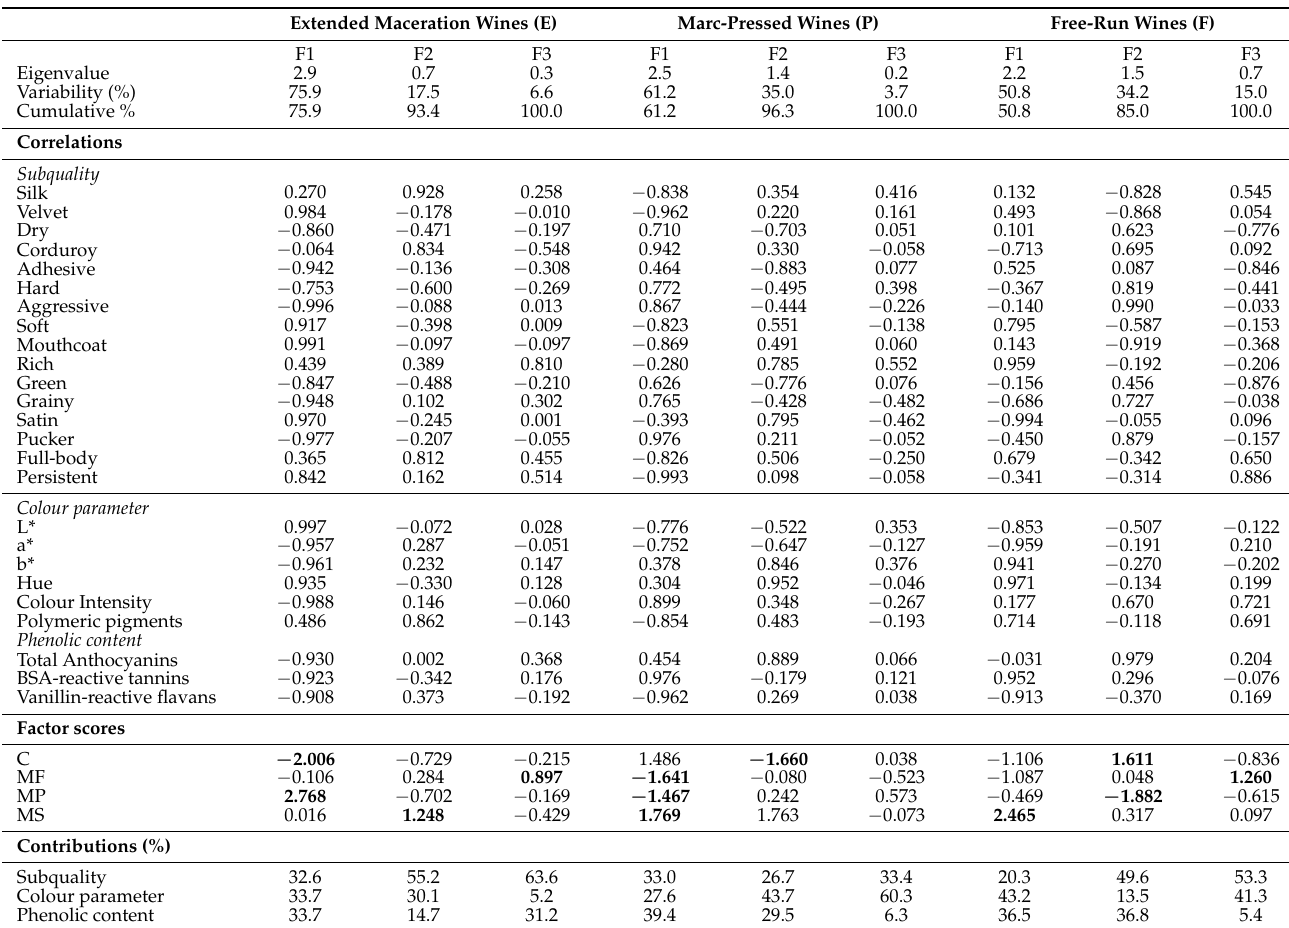
Table 2. Relationships from the Multiple Factor Analysis between the variables: astringency subqualities (silk, velvet, dry, corduroy, adhesive, aggressive, hard, soft, mouthcoat, rich, full-body, green, grainy, satin, pucker, and persistent); colour parameters (colour intensity, hue, a*, b*, L*, and polymeric pigments); and phenolic content of the wine (total anthocyanins, BSA-reactive tannins, and vanillin-reactive flavans) and factors: C = control and mannoprotein treatments = MF, MP, and MS for extended maceration (E), marc-pressed (P), and free-run (F) wines. Extended Maceration Wines (E)